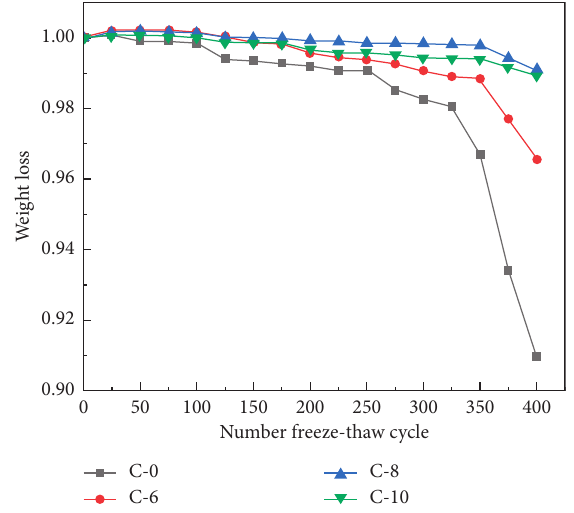
Figure 6: Weight loss of